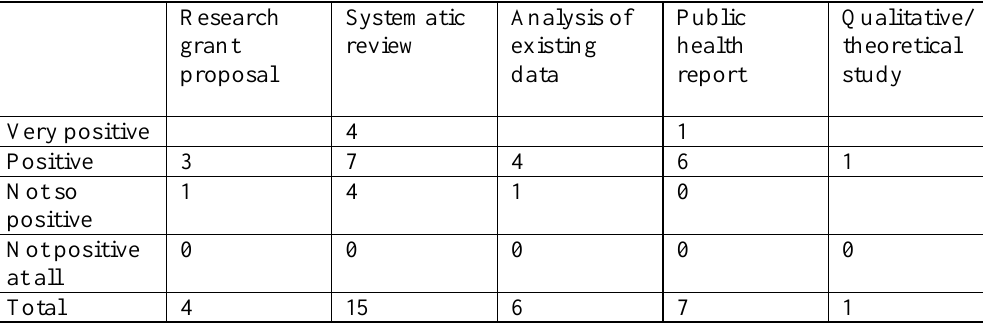
Level of Satisfaction Overall by Type of Dissertation